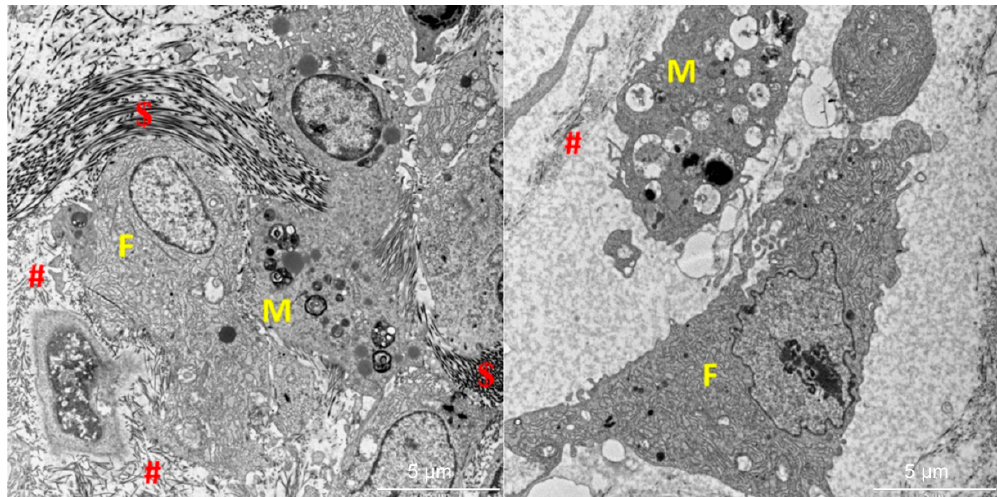
Figure 5. Representative electron microscopy images of healing skin defects in group A ( left ) and control group ( right ). Fibroblasts with heavily developed rough endoplasmic reticulum (F) and macrophages (M) were the most numerous cell types found in all samples. The voluminous extracellular matrix (ECM) contained collagen fibrils with a greater amount and higher degree of organization (fibers) in group A ( left ) and group B than in group C (#—ECM with collagen fibrils; $—collagen fiber). In groups A ( left ) and B, there were thinner fibrils (40 nm) and thicker fibrils (80 nm). This may indicate more intensive collagen production in groups A and B compared to the control group. The bars represent 5 μ m.